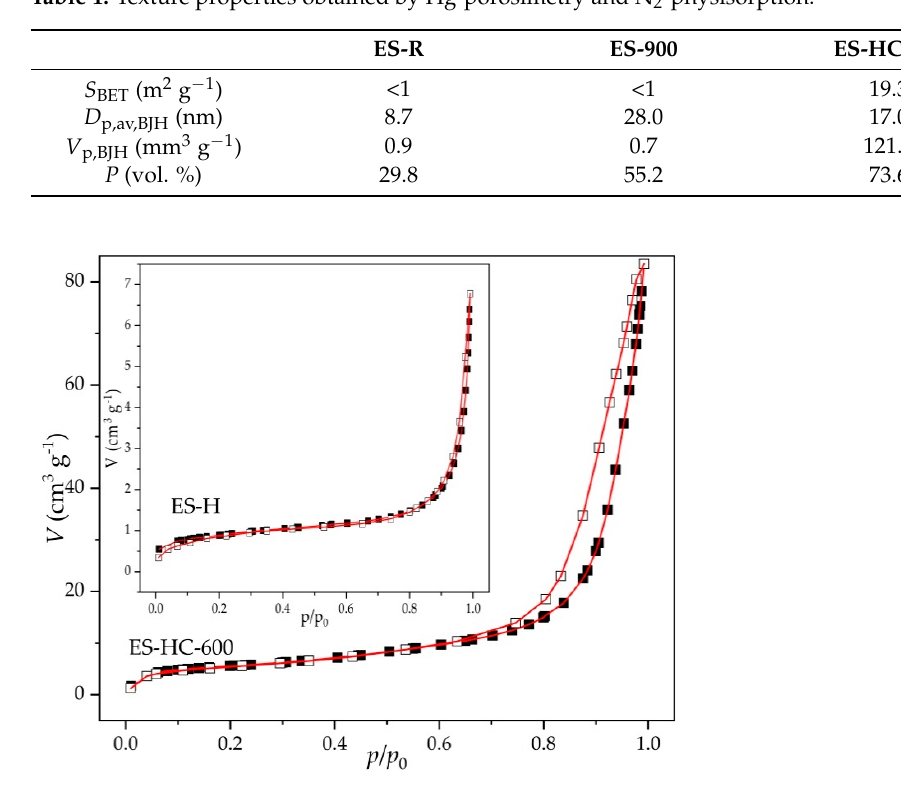
Figure 6. N 2 -adsorption-desorption isotherms of ES-H and